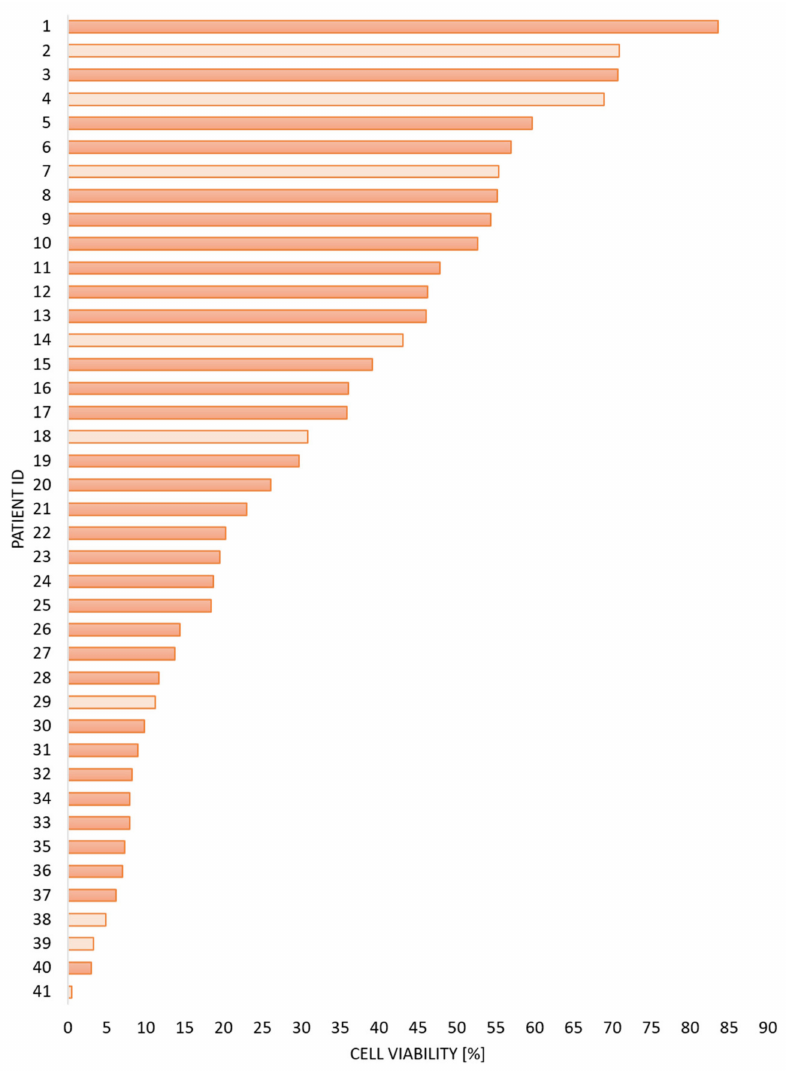
Figure 1. The variation in spontaneous stress-induced AML cell apoptosis between patients. Pri- mary AML cells were derived from 41 consecutive patients. The cells were separated/enriched, cryopreserved, and stored frozen in liquid nitrogen until they were thawed and cultured in vitro for 48 h before the percentages of viable-early apoptotic-late apoptotic/necrotic cells were determined by flow cytometry. The figure presents the percentage of viable AML cells (x-axis) derived from 41 individual patients (y-axis, patient number/identity) at the end of the culture period. The median viability for all 41 patients was 23.0% (range 0.5–83.6%). The results are presented as the percentage of viable cells. The 32 patients included in the proteomic studies (see Sections 3.2–3.5) are indicated by dark color and based on the median viability level in this analysis of overall viability data including 41 patients; we used 25% viable cells as the cut-off between high and low viability